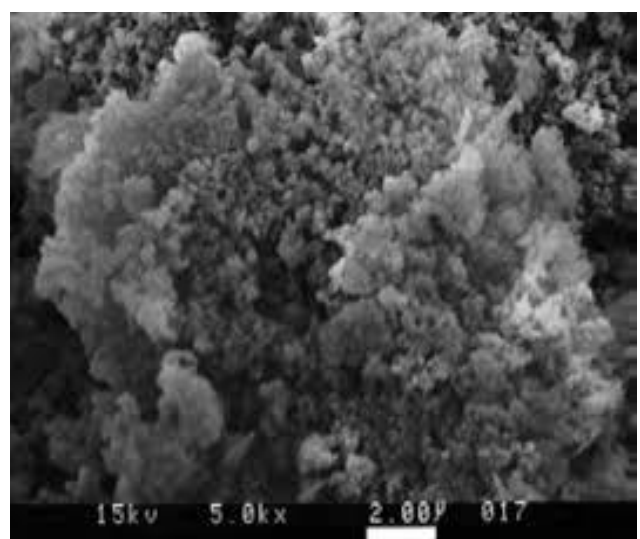
Fig. 3. SEM of Alccofine